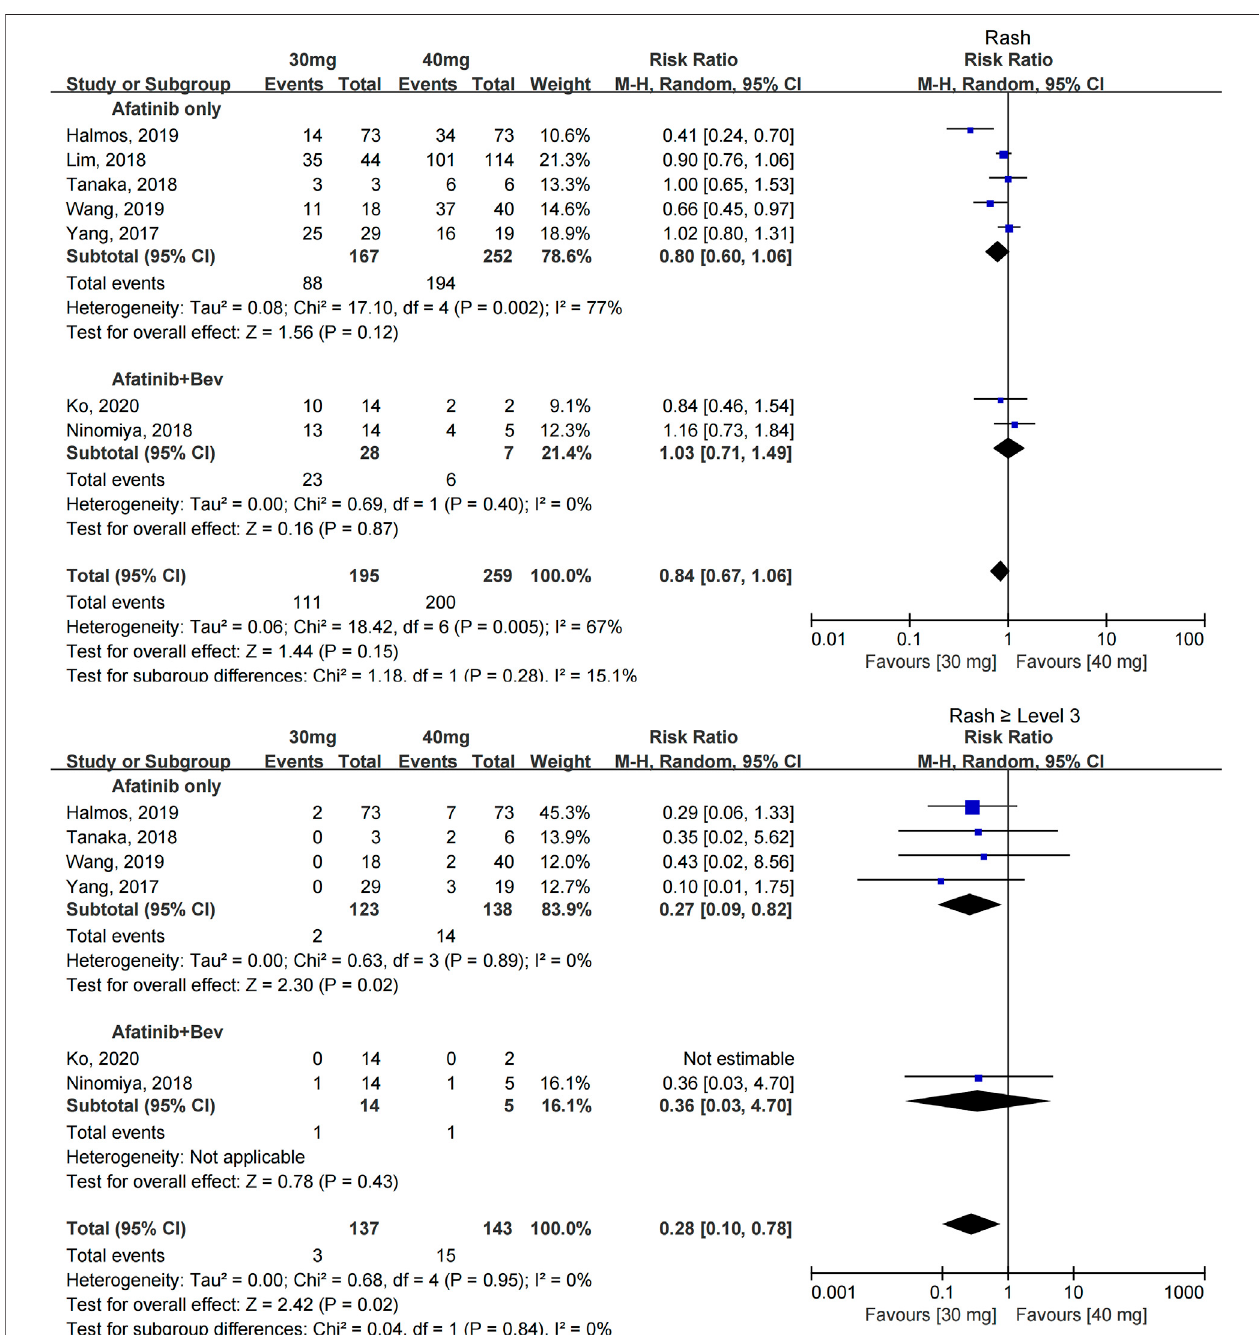
FIGURE 4 | Forest plot of the incidence of rash and ≥ grade 3 rash in the meta-analysis of patients treated with 30 and 40 mg of afatinib.